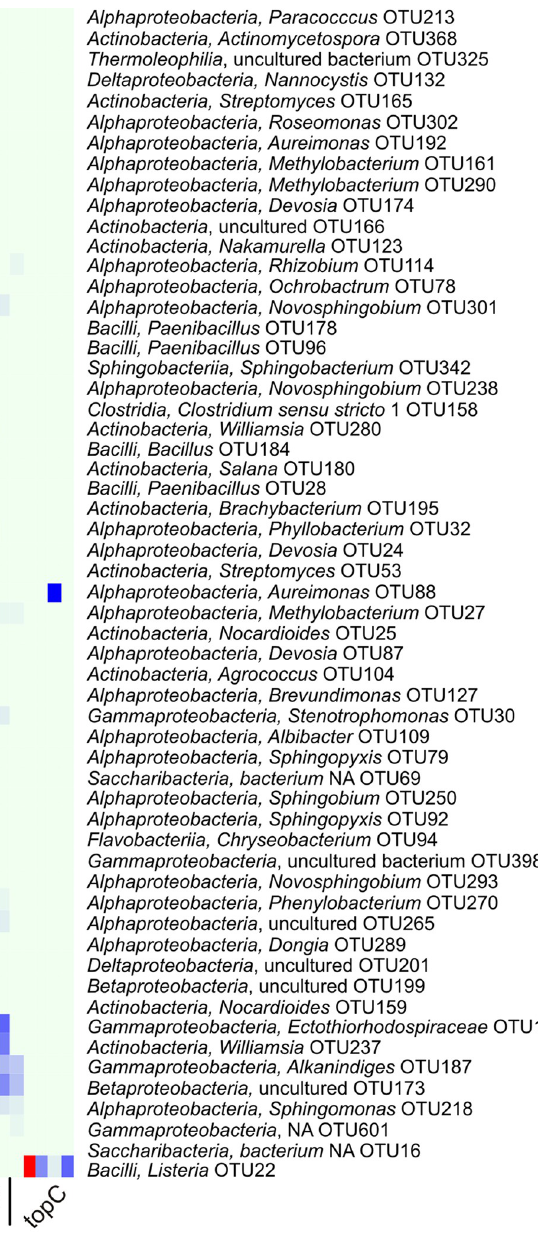
Fig 5. Species that are characteristic to the peel and pulp of five root vegetables. Relative abundances of OTUs specific to only one vegetable compartement (P- value < 0.001) were clustered using Bray-Curtis dissimilarity and depicted on a heatmap. The class and genus of the OTUs are indicated. Abbreviations: neepC– neep pulp; neepP–neep peel; carC–carrot pulp; carP–carrot peel; topC–topinambur pulp; topP–topinambur peel; potC–potato pulp; potP–potato peel; beetC–beet pulp; beetP–beet peel. We included only those OTUs whose read counts in all samples was more than 50 in the